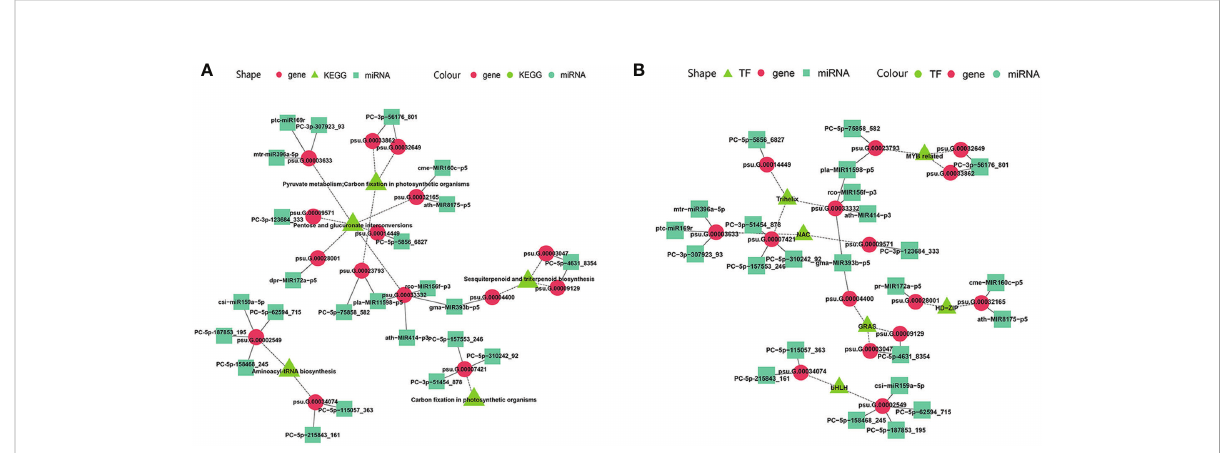
FIGURE 8 MiRNA-mRNA-TF modules regulatory network identi fi ed by miRNAome, transcriptome and degradome integrated analysis across fl ower developmental stages and varieties of tree peony (A) Regulatory network mediated by miRNA-mRNA-TF modules identi fi ed across fl ower developmental stages in FD, MU, and LH. (B) Regulating network mediated by miRNA-mRNA-TF modules identi fi ed across tree peony varieties at fl ower developmental stages BS, IF, FB,